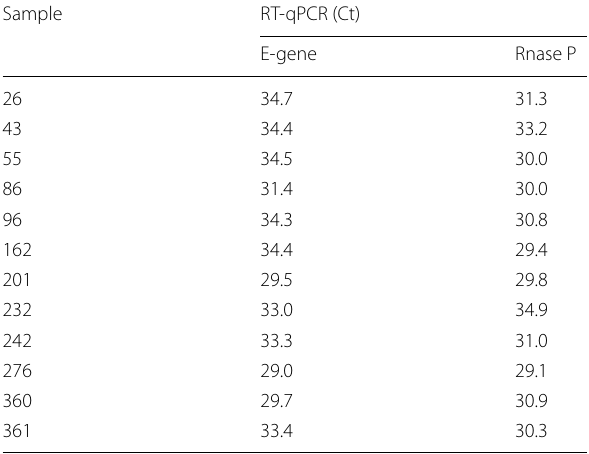
Table 5 Association between self-reported days of symptoms and RT-qPCR SARS-CoV-2 positive patients and colorimetric RT-LAMP performance